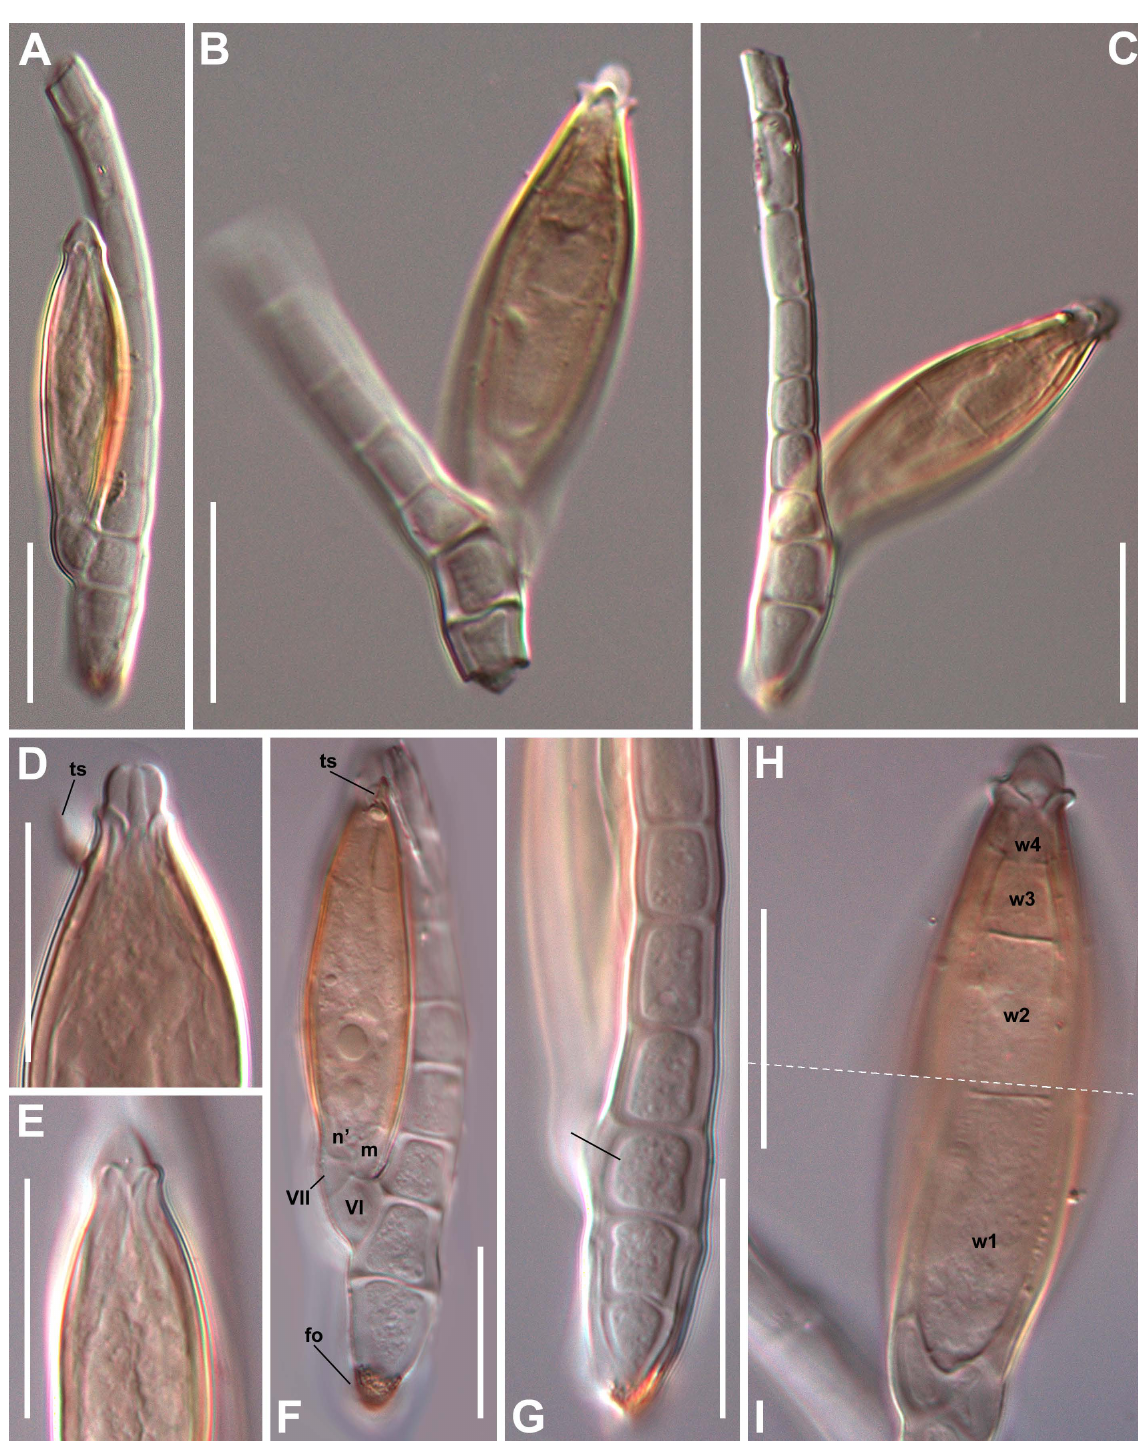
Fig. 64. Tanmaurkiella pselaphi Santam. gen. et sp. nov. A – C . Mature thalli. D . Perithecial tip in detail, showing trichogyne scar (ts) out of focus. E . Perithecial tip in detail. F . Mature thallus showing labelled VI, VII, m, and n′ cells, foot (fo), and trichogyne scar (ts). G . Third cell of the axis is labelled with a black line. H – I . Perithecium in detail with different focus level above and below the stippled line to have in focus outer wall cells (w ). Scale bars: A–C = 25 µm; D–I = 20 µm. Photographs from slide ZMUC n C-F-124165